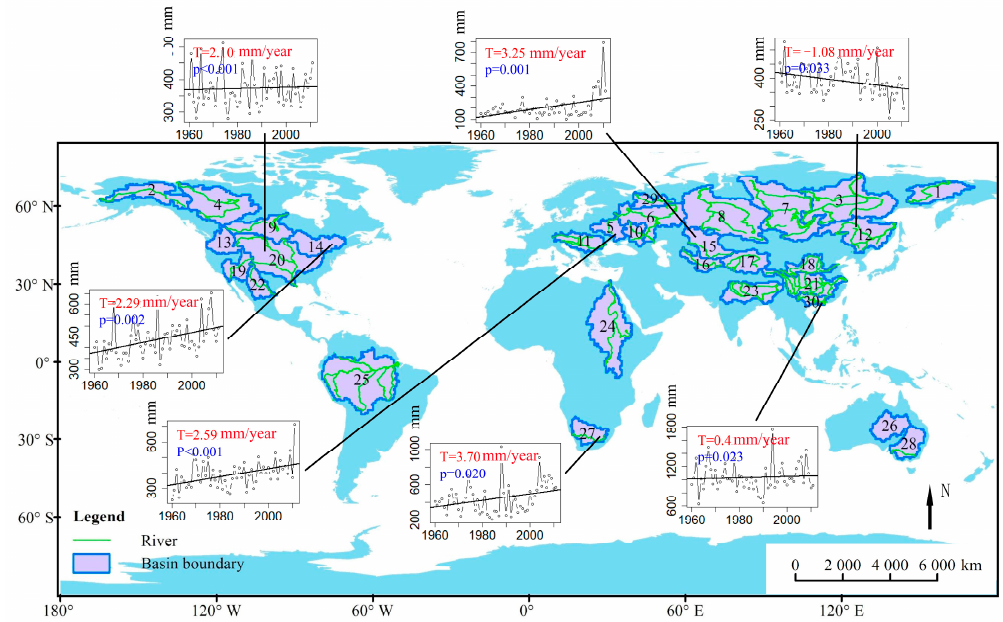
Figure 3. Trends in maximum five-day precipitation (RX5day) for different river basins. The x-axis in each panel shows the time and the y-axis is the amount of RX5day for the corresponding year. Numbers within basins signify basin ID as listed in Table 1.